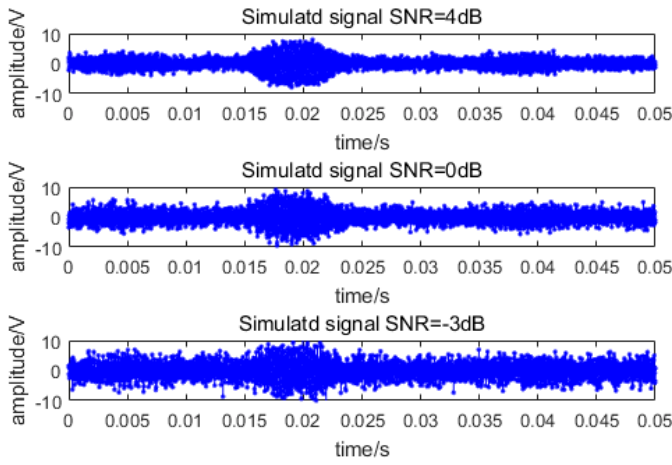
Figure 3. Simulated echo signals with different signal-to-noise ratios.